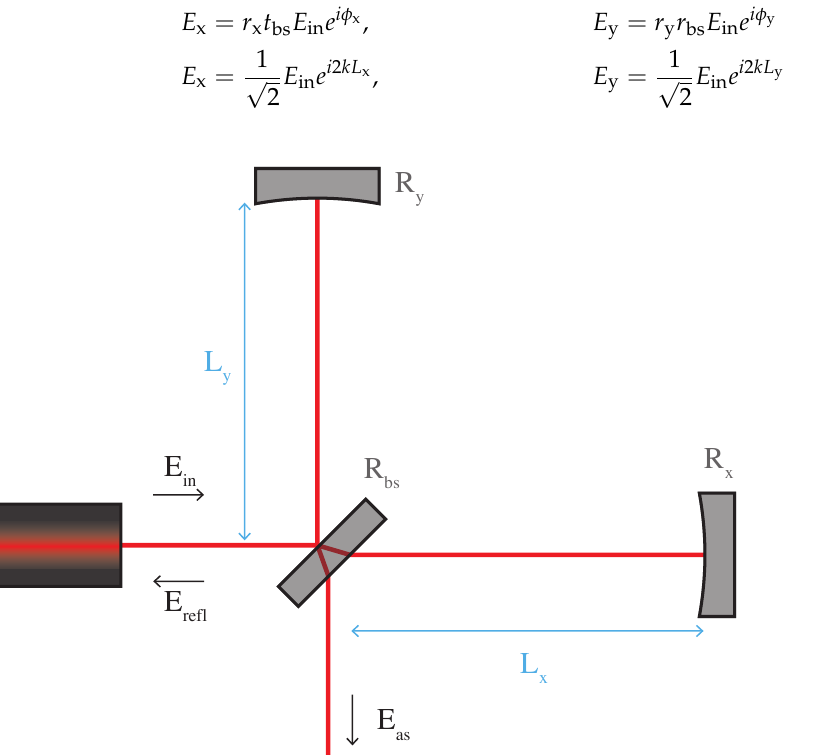
Figure A1. Optical layout of a Michelson interferometer. The input laser electric field is E in , the field reflected from the Michelson is E refl , and the field transmitter through the Michelson antisymmetric port is E as . The 50:50 beamsplitter R bs = r 2 transmits half to the X-arm. The highly reflecting end mirrors R x directly back to the